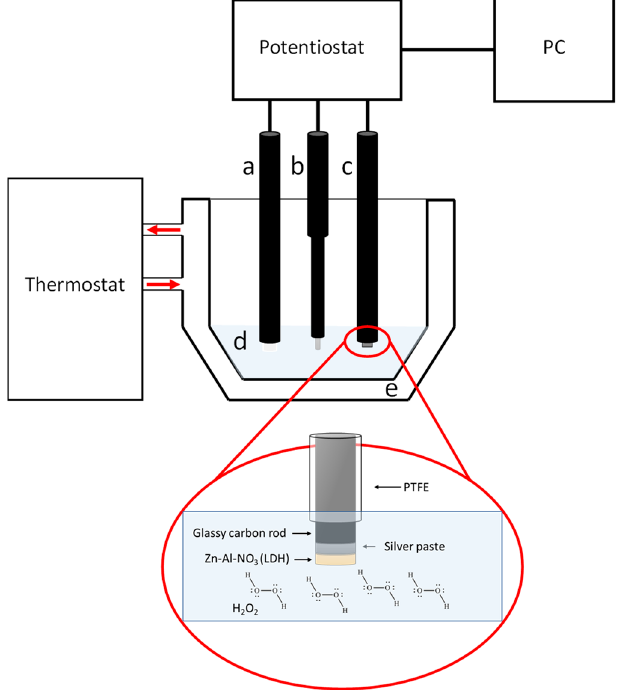
Figure 3. Schematic of the three-electrodes voltammetric system used in the present research for proline measurement: (a) counter electrode, (b) reference electrode, (c) working electrode, (d) hydrogen peroxide in PBS containing KCl, and (e) thermostated electrochemical cell. In the inset a schematic representation of the catalytic sensor GC-Ag (paste) -LDH-H 2 O 2 , is shown.